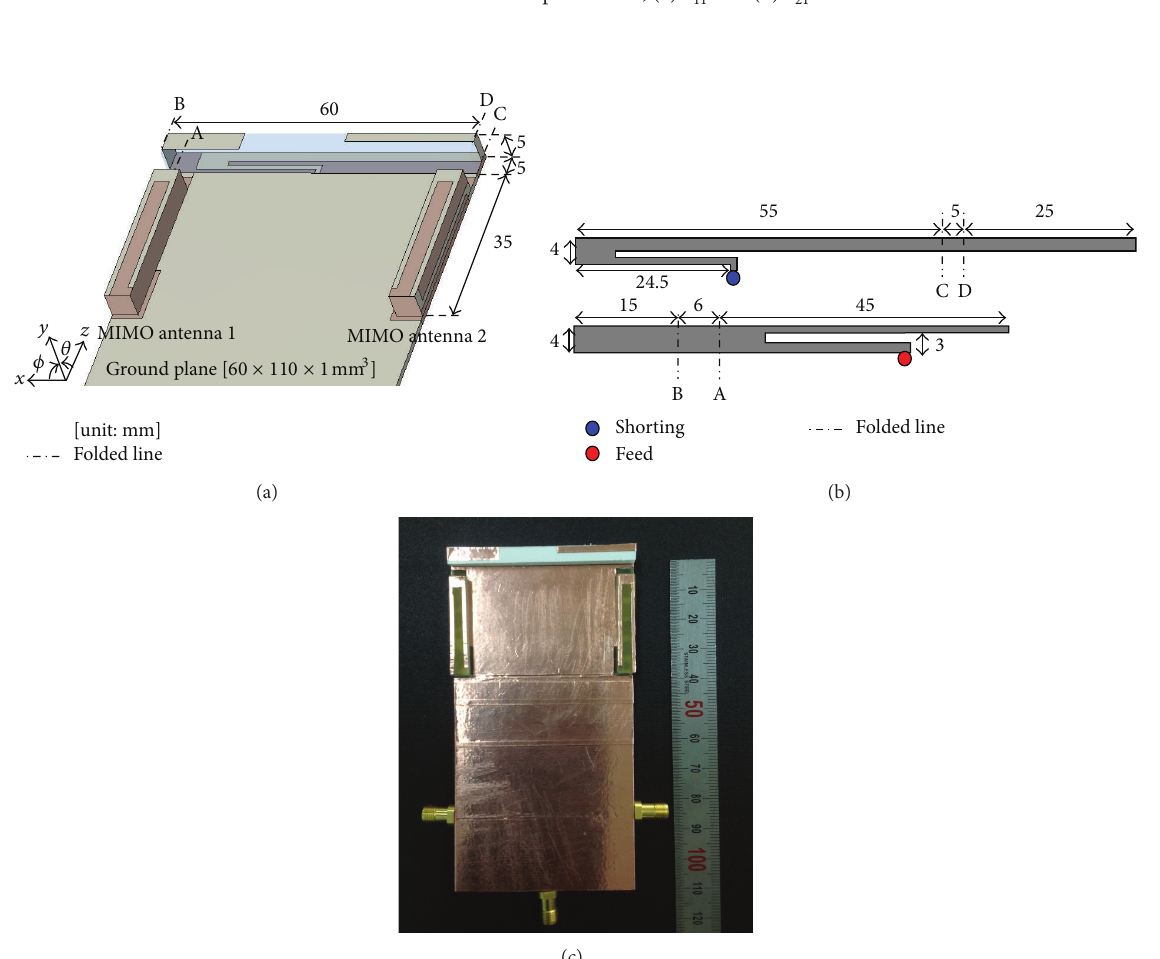
Figure 4: Simulated 𝑆 -parameters; (a) 𝑆 11 and (b) 𝑆 21 .